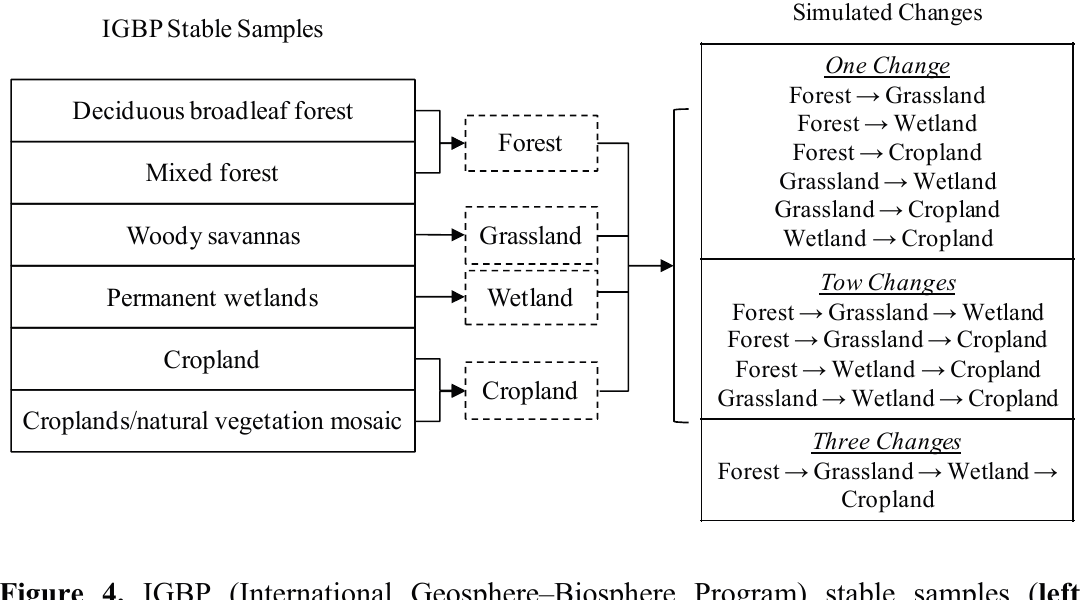
Figure 4. IGBP (International Geosphere–Biosphere Program) stable samples ( left ); grouped land-cover types ( middle ) and simulated changes ( right